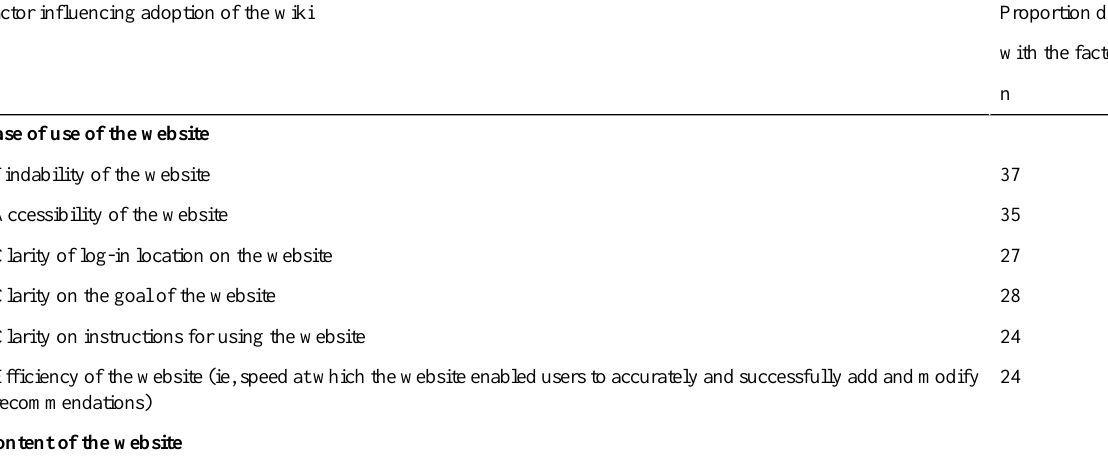
Table 3. Patients’barriers to adoption of the wiki (n =